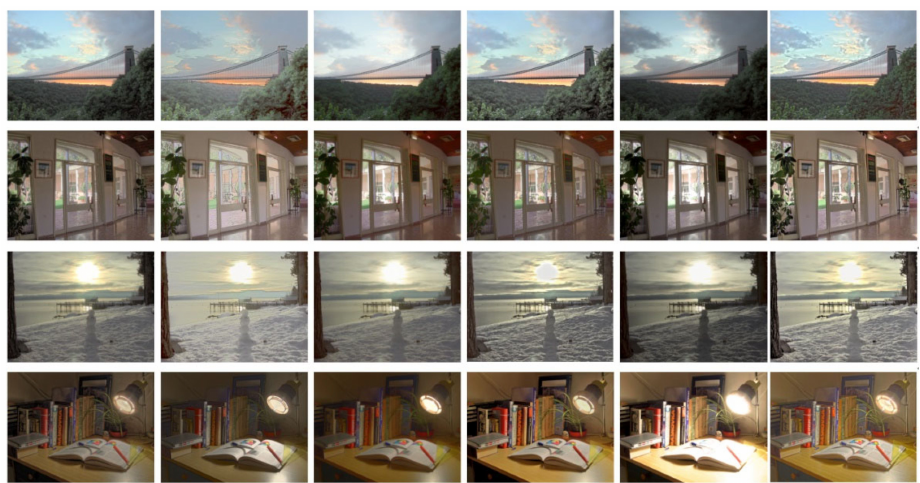
Figure 11. Four groups of tone-mapped images were obtained by our algorithm and the compared algorithms. The order of sub-photographs keeps in line with Figure 7.